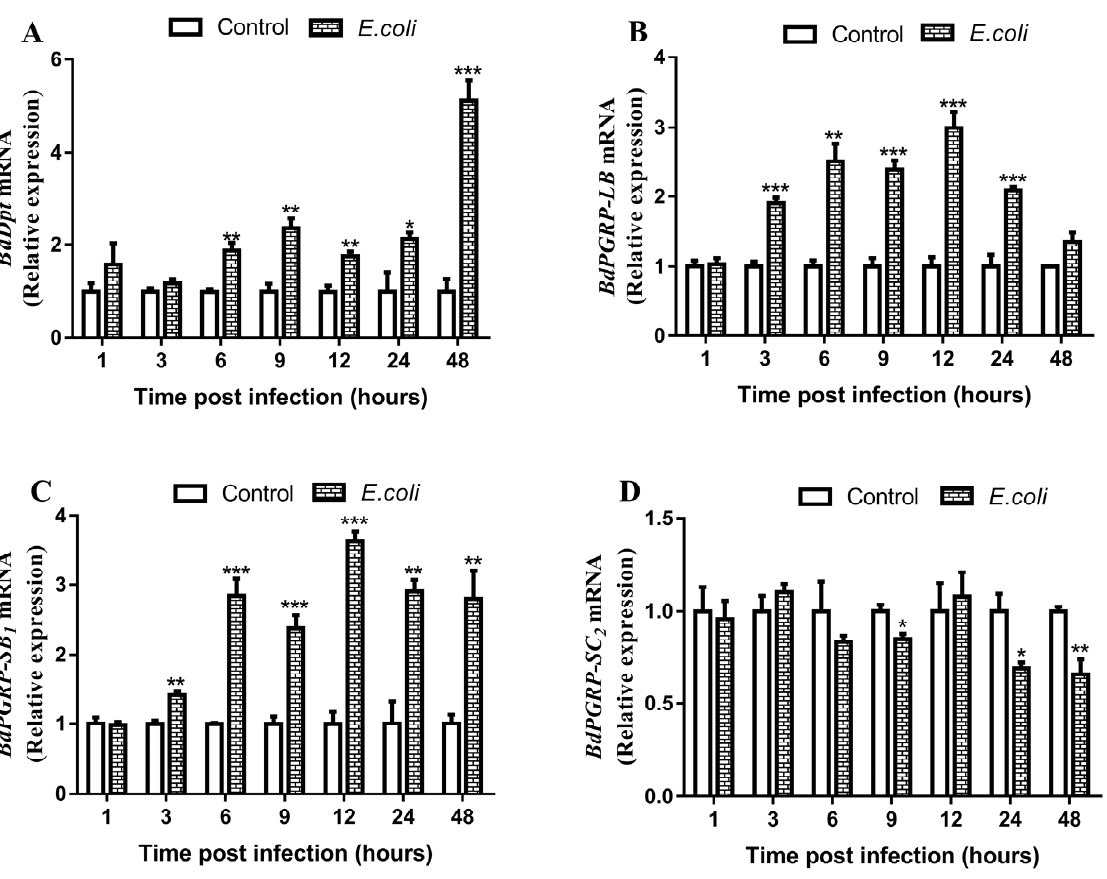
Figure 3. Responses of Dpt and BdPGRPs to opportunistic pathogen E. coli challenges. Relative expression of Dpt ( A ), BdPGRP-LB ( B ), BdPGRP-SB 1 ( C ), and BdPGRP-SC 2 ( D ) after infection with E. coli at different time points, respectively. The data are expressed as mean ± SEM and the mean refers to the average of four biological replicates for each sample. Statistical analysis was based on Student’s t -test. * p < 0.05; ** p < 0.01; *** p < 0.001. The relative gene expression data were analyzed using a 2 − ∆∆ CT method and the data were normalized to reference gene Rpl32